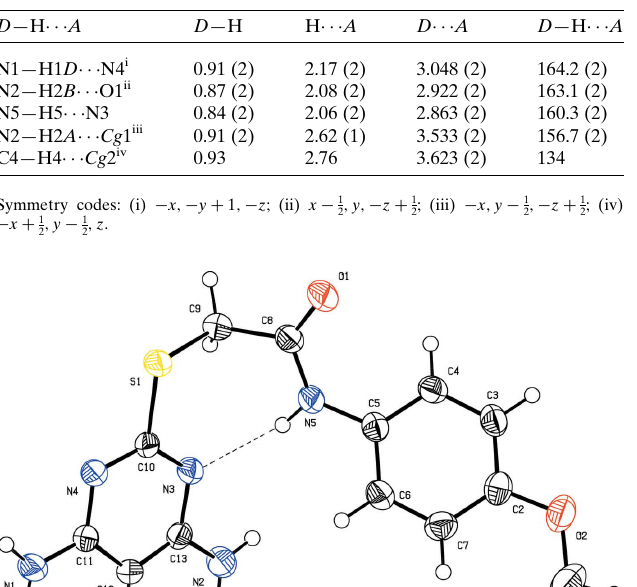
Table 1 Hydrogen-bond geometry (A˚ , (cid:2) ). Cg 1 and Cg 2 are the centroids of the N3/C10/N4/C11–C13 and C2–C7 rings, respectively.